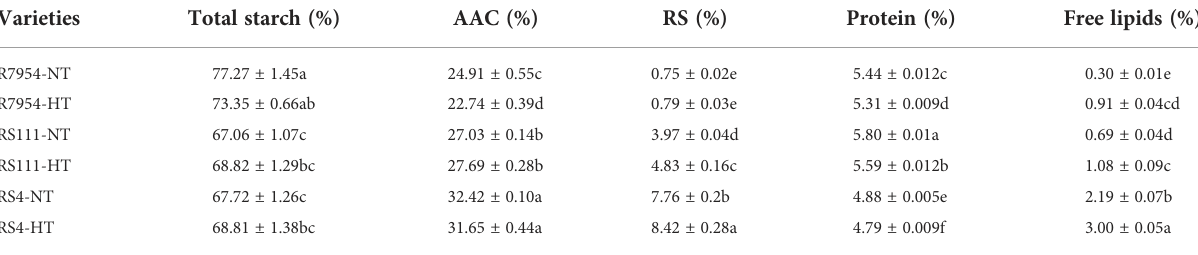
TABLE 1 Main components of the three varieties under NT and HT*.